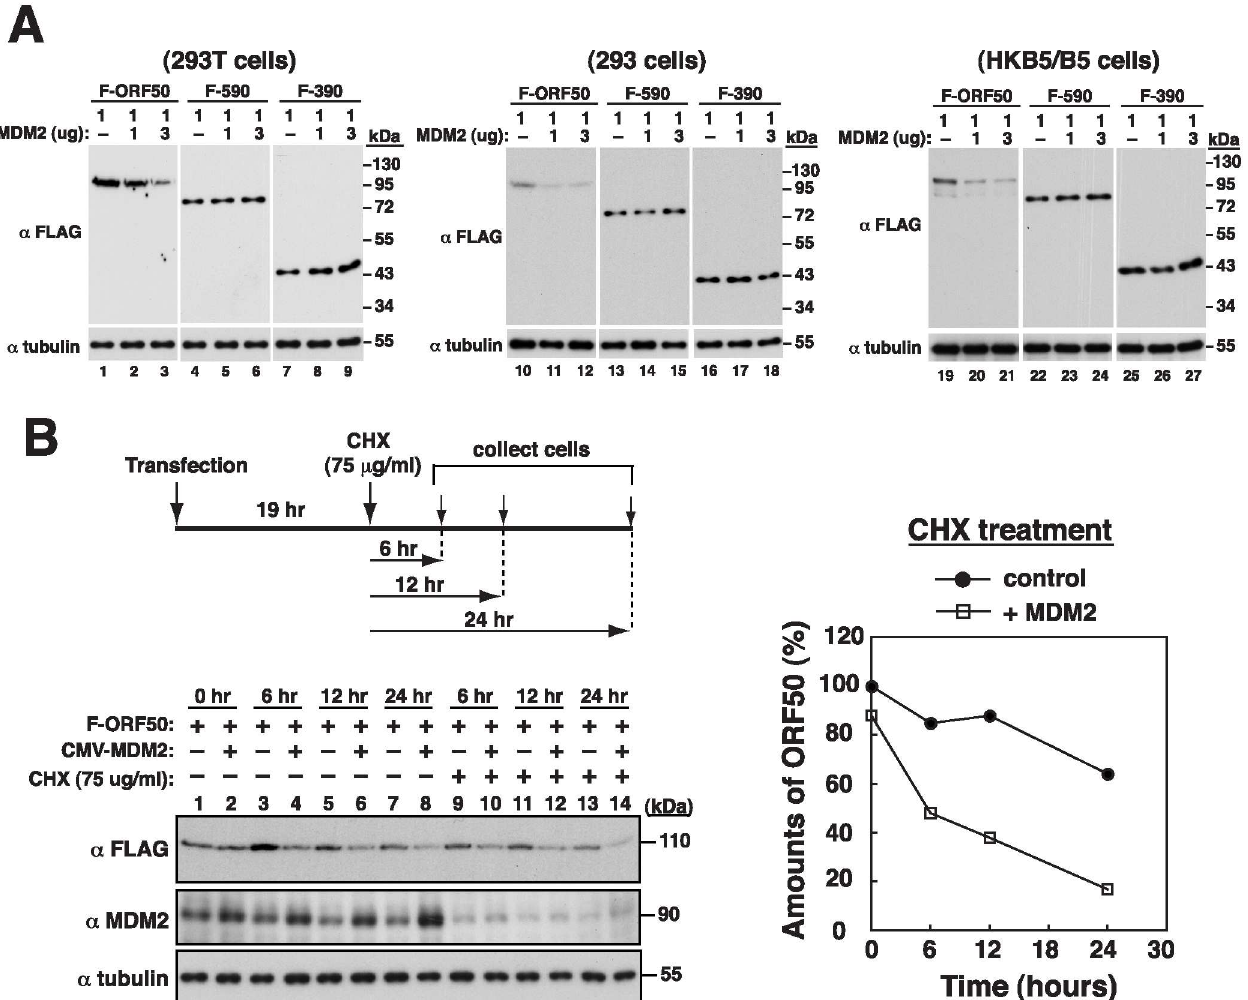
Fig 8. Human MDM2 promotes ORF50 degradation. (A) Effect of MDM2 expression on ORF50 abundance. Increasing amounts of an MDM2 expressionplasmid, pCMV6-XL-MDM2, were cotransfected with a plasmid expressingF-ORF50, F-590 or F-390 in 293T, 293 or HKB5/B5 cells. At 24 hr after cotransfection, the expression of these ORF50 proteins was examinedby immunoblotting. (B) Evaluationof the half-life of ORF50 in MDM2-transfected cells. 293T cells were cotransfected with an F-ORF50 expression plasmid and pCMV6-XL-MDM2 or control vector. At 19 hr after transfection, cells were untreated or treated with cycloheximide for another 6, 12 and 24 hr. The expression of F-ORF50 and MDM2 were analyzedby immunoblotting with anti-FLAG and anti-MDM2 antibody, respectively. The relative levels of F-ORF50 from immunoblots (left panel) were quantifiedby densitometry and normalizedto tubulin, which are depicted in the right panel.